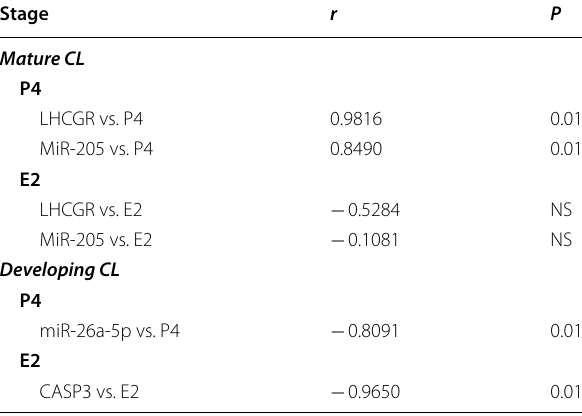
Table 3 The correlation between miRNAs, target genes, and serum steroid levels (P4 and E2) during different stages of corpus luteum in